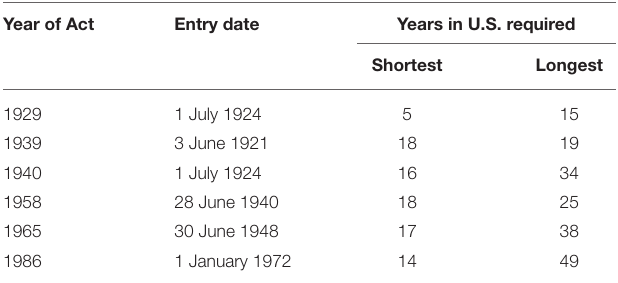
TABLE 2 | Legalization of unauthorized: U.S. immigration registry